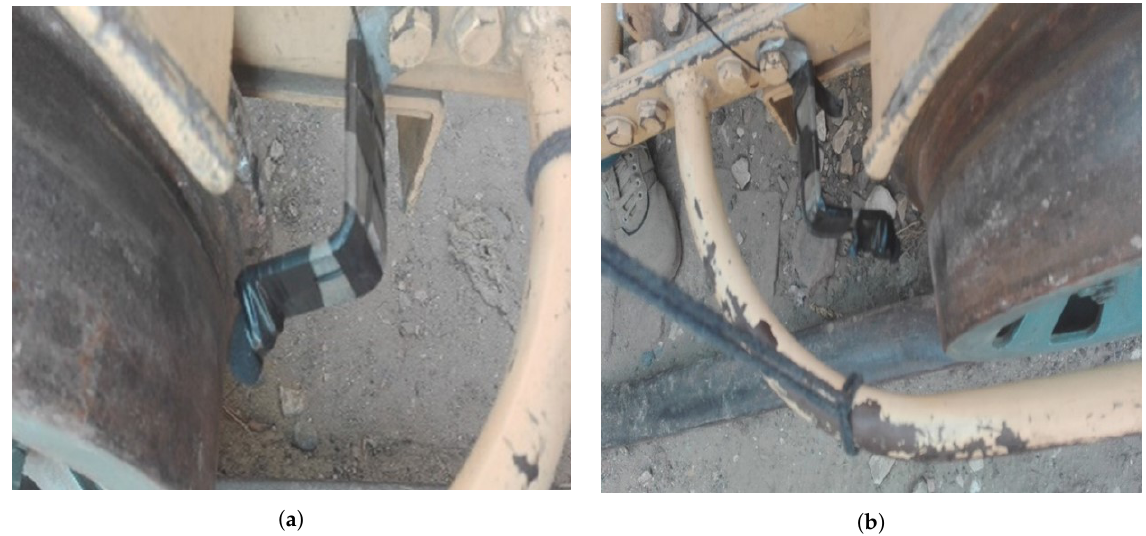
Figure 5. Pictures of wheels in contact with the track. ( a ) Assembly of microphone on left side of the mechanical cart; ( b ) Assembly of microphone on right side of the mechanical